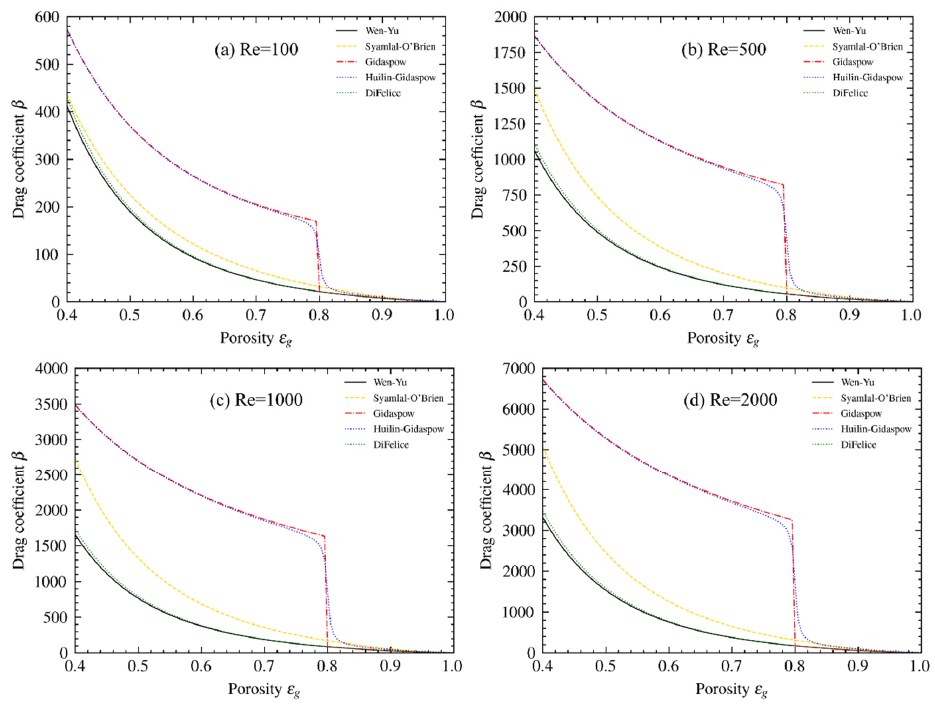
Figure 7. Comparison of experiment-based drag models in conditions of ( a ) Re = 100, ( b ) Re = 500, ( c ) Re = 1000 and ( d ) Re = 2000.